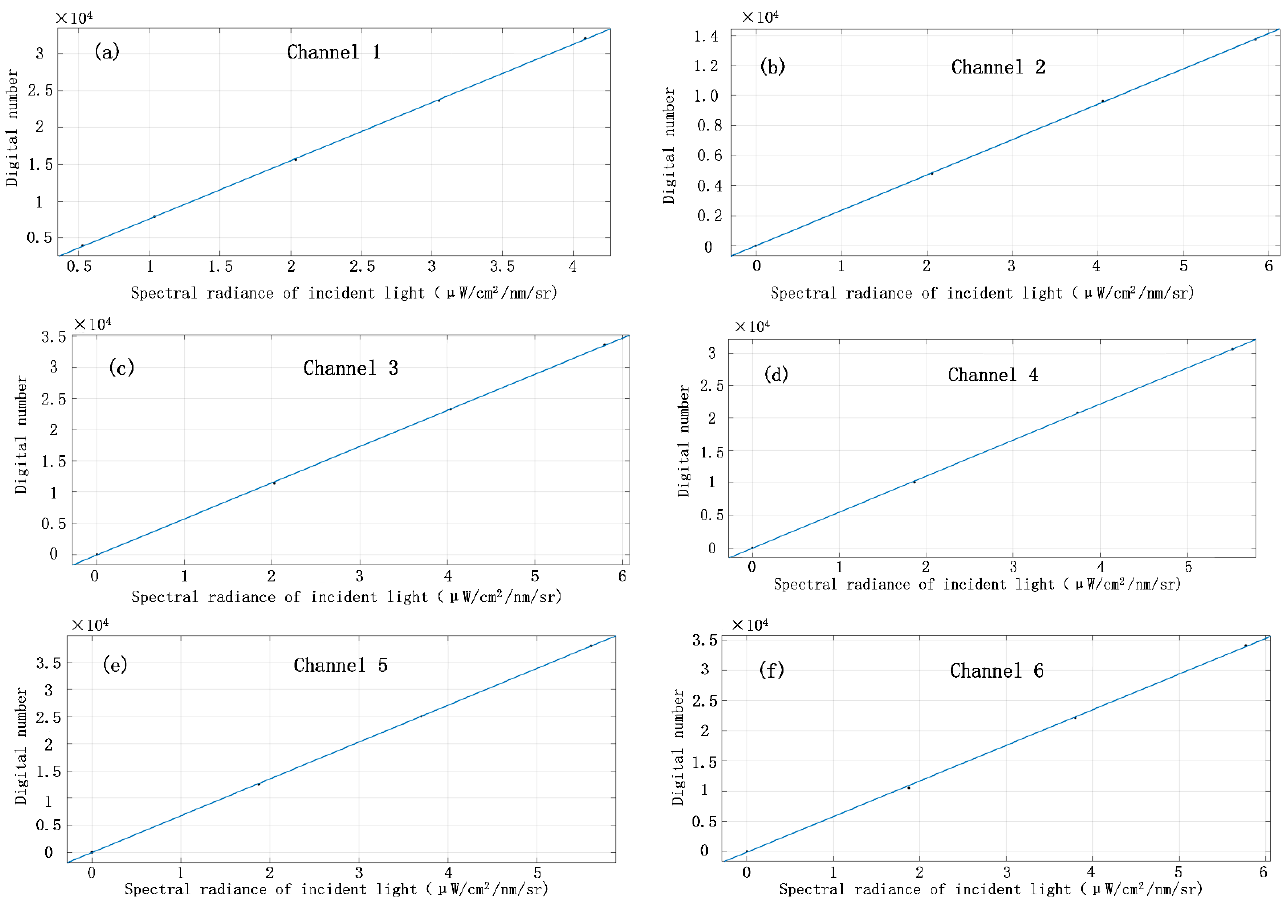
Figure 19. Fitting results of the linear radiance response of the 1024 PBSC for the six channels: ( a ) Channel 1; ( b ) Channel 2; ( c ) Channel 3; ( d ) Channel 4; ( e ) Channel 5; ( f ) Channel 6.